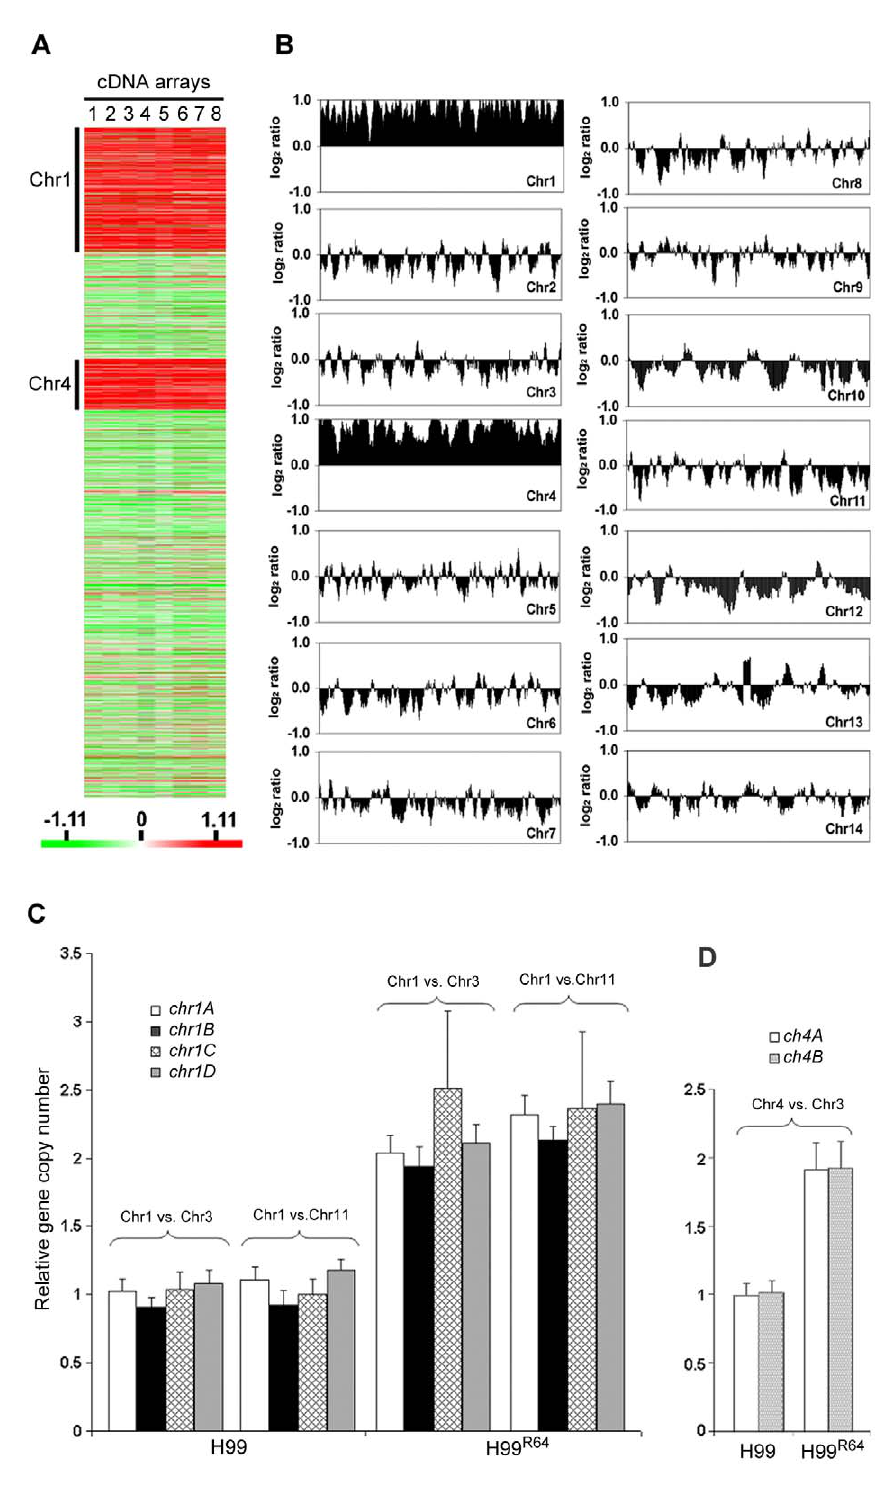
Figure 2. Chromosome 1 and 4 are duplicated in H99 R64 . ( A ) Gene expression profiles. Gene expression patterns of H99 R64 were compared to those of the wild type strain, H99. A total of eight arrays including three biological repeats and dye-reversed sets were performed as described in materials and methods. Each column (lane 1 to 8) represents a microarray experiment and each row represents the expression of a gene on the array arranged by its chromosomal position. A total of 4149 significant genes were plotted after SAM analysis with a mean FDR of 5%. Chromosomes where upregulated genes are clustered are indicated. The relative expression levels are represented by color as shown in the bar. ( B ) CGH plot of H99 R64 . The genomic DNA of the experimental strain was hybridized against the genomic DNA of the reference strain, H99. Each panel represents the CGH plot of each chromosome. Chromosome number is indicated in the right side corner of each panel. The x-axis represents the position of each gene